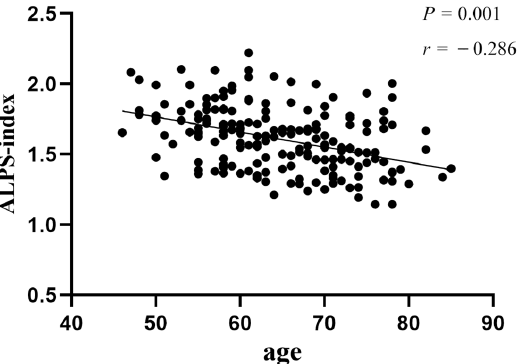
Figure 4. Correlation between ALPS-index and age in all CSVD patients. Abbreviations: ALPS-index, the index of Diffusion Tensor Image Analysis along the Perivascular Space; CSVD, cerebral small vessel disease.